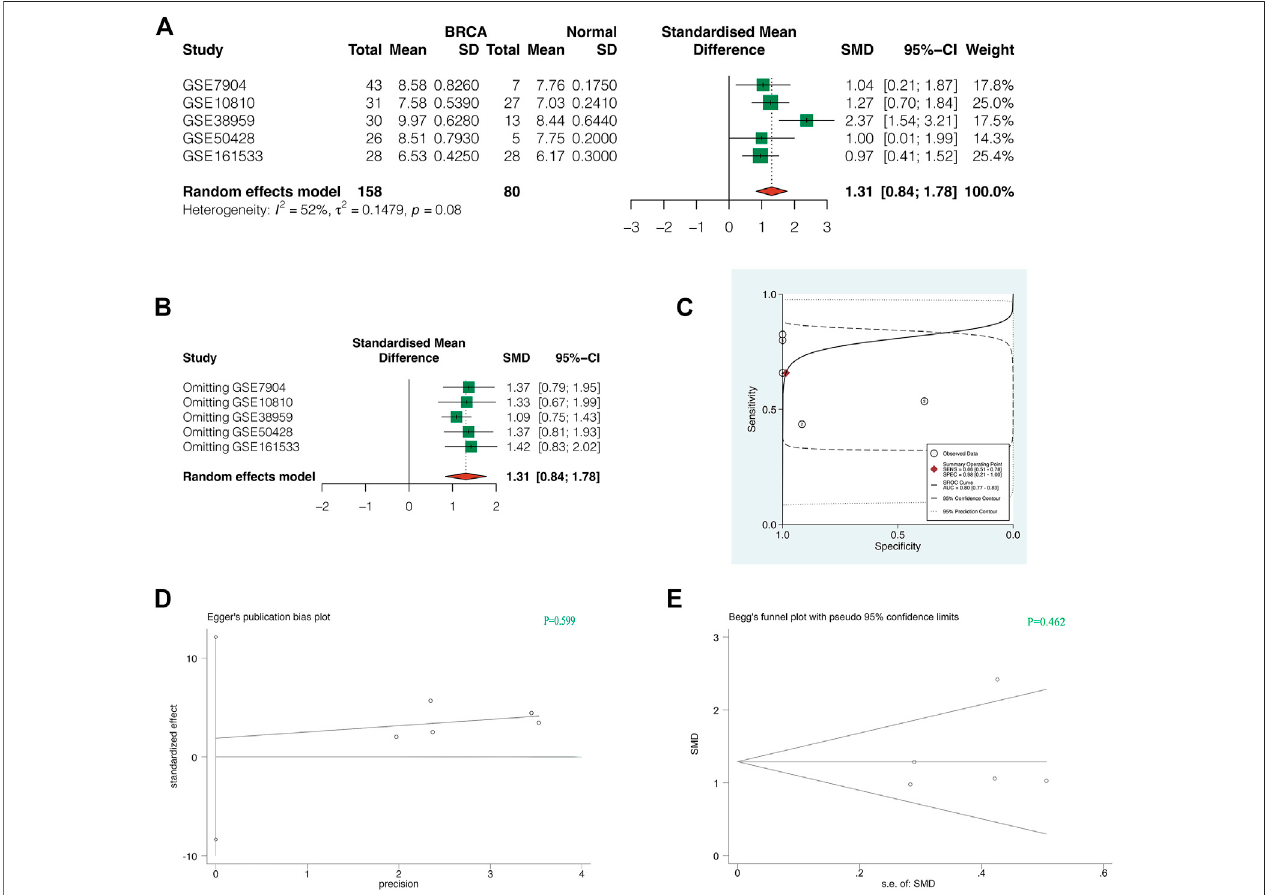
FIGURE 5 | Comprehensive analysis of GTPBP4 in multiple GEO datasets. (A) The random effect model was used for analysis due to heterogeneity I 2 > 50%. The combined SMD was 1.31, 95%CI was [0.84, 1.78]. (B) Sensitivity analysis showed that the results of our meta-analysis were reliable. (C) The AUC value of sROC curve was0.80, indicating good diagnostic accuracyofGTPBP4 (D,E) The p -valueofEggertestwas0.599,andthe p -valueofBegg testwas0.462,indicatingthattherewas no obvious publication bias.